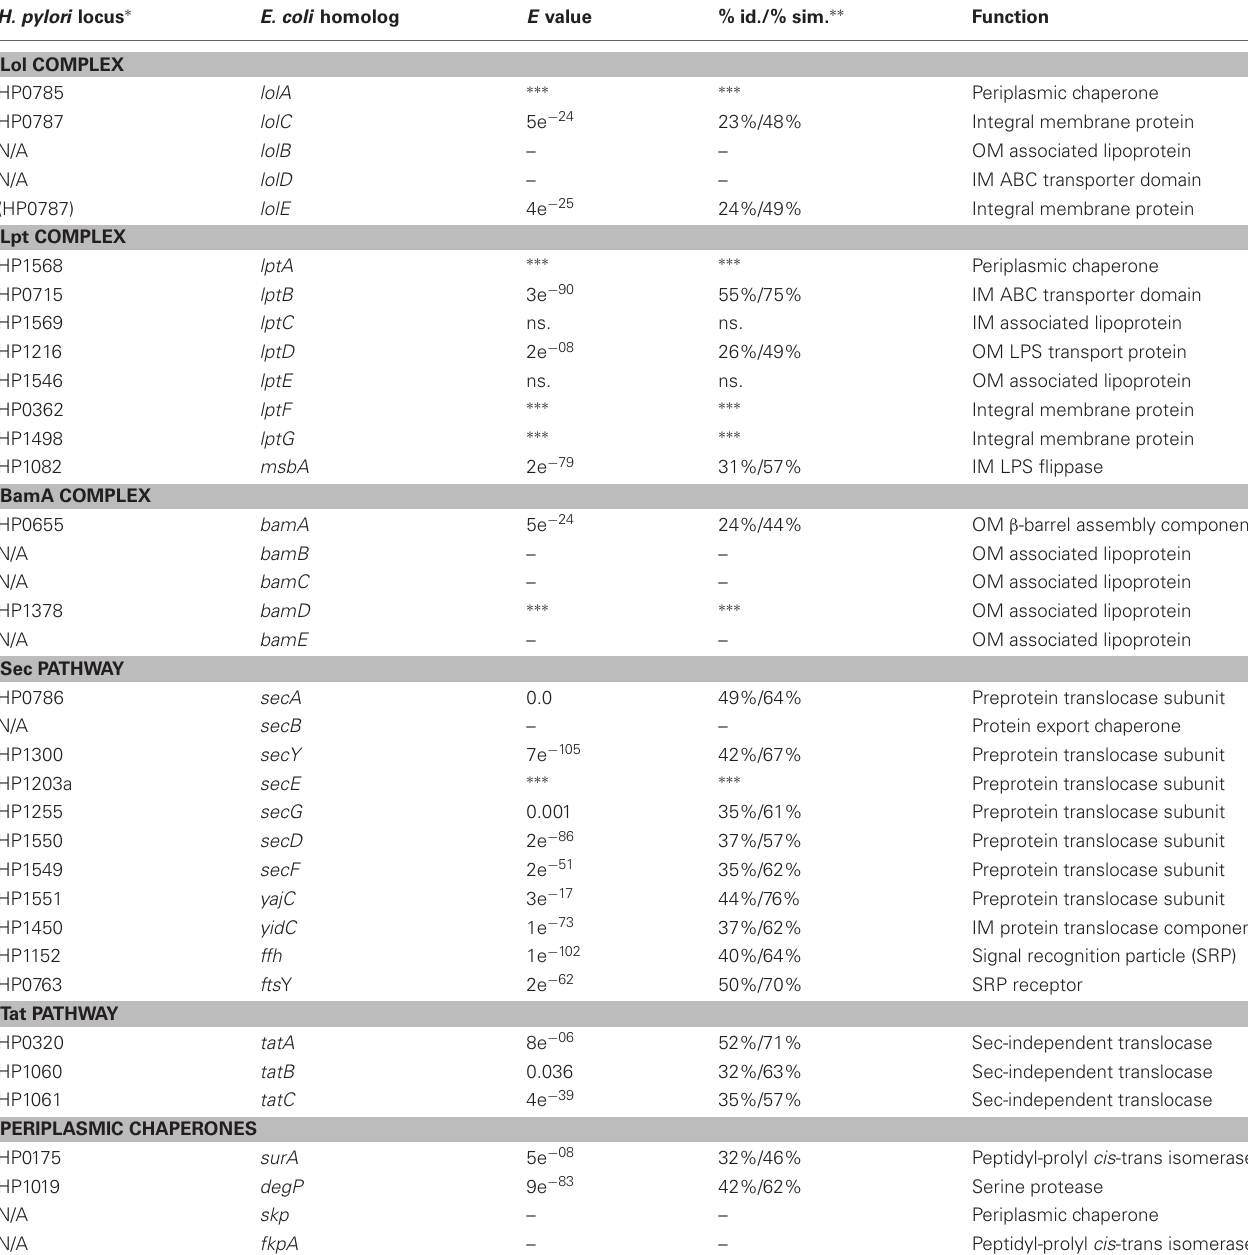
Table 1 | H. pylori putative outer membrane biogenesis complex